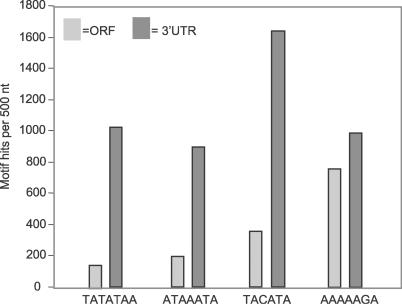
Distribution of Nab4 Motifs in the Genome Is Biased Toward the 3′ UTRGraph displaying the occurrence of Nab4 motifs throughout the genome per 500 nucleotides. Occurrences in ORF sequences are in light gray; 3′ UTR hits are in dark gray. Another sequence (AAAAAAG) associated with Nab2 was included for comparison. nt, nucleotide.